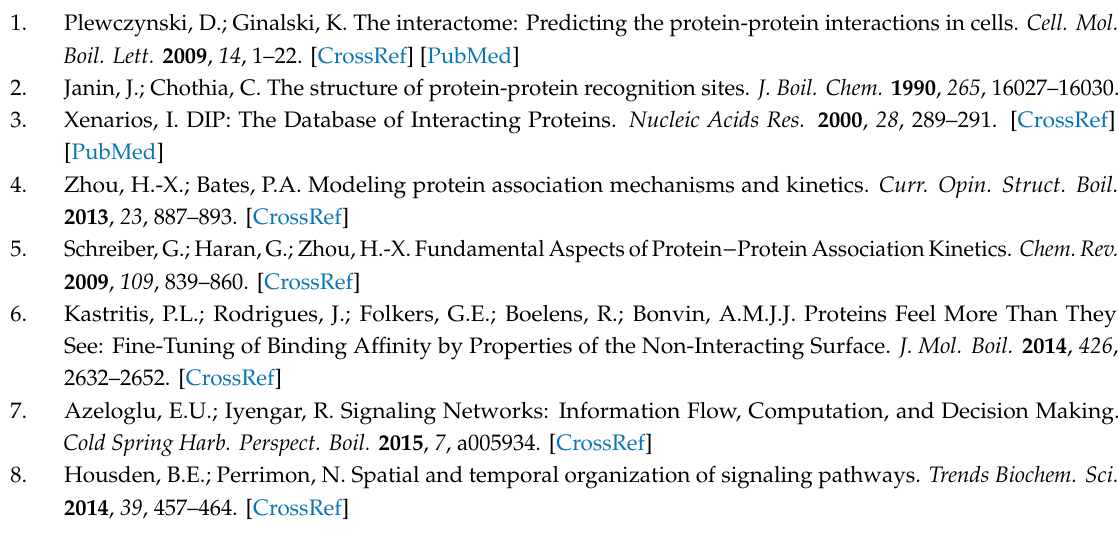
Table S1: the list of all protein complexes in the